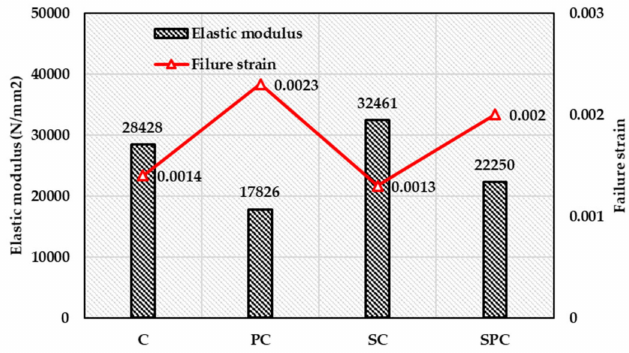
Figure 11. Failure strain and elastic modulus of impermeable concrete after a 28-d curing